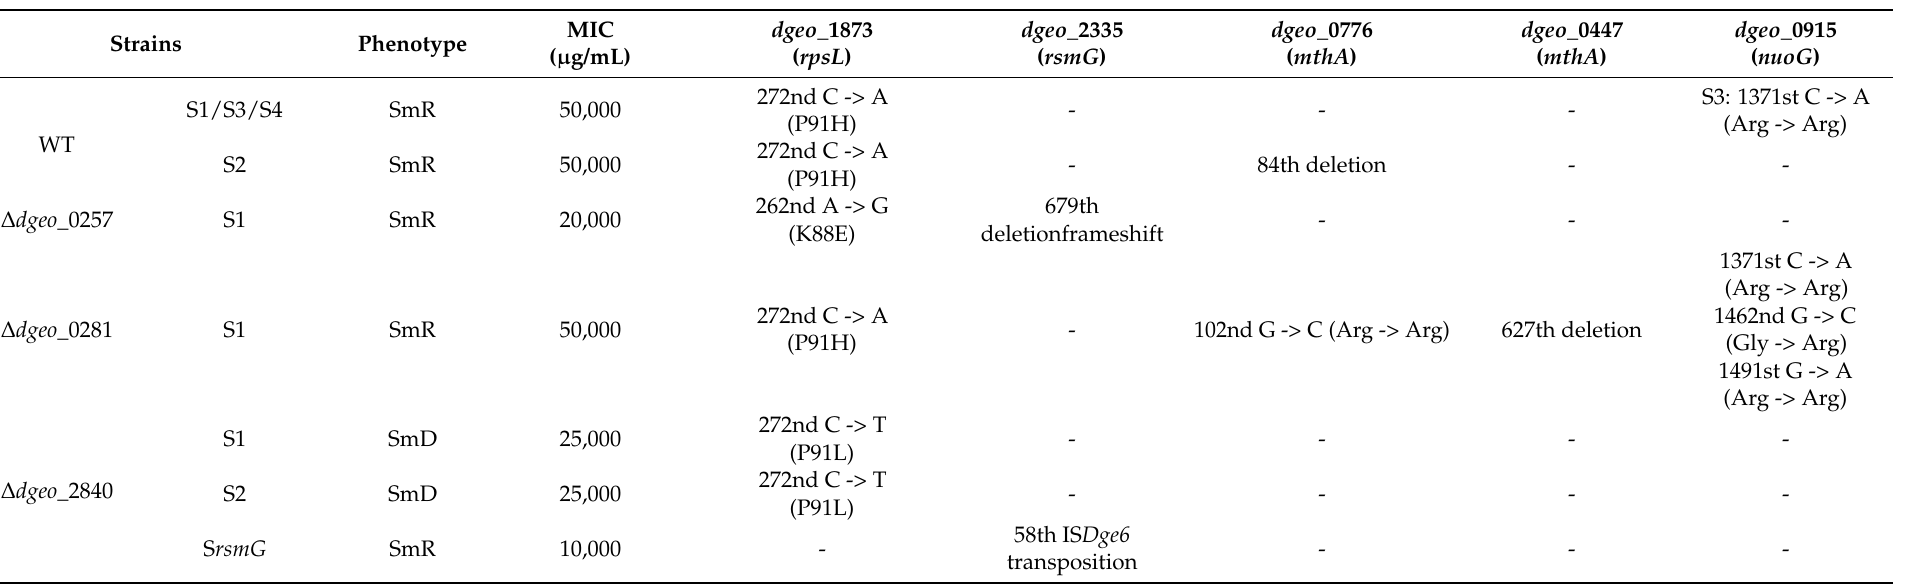
Table 1. Detection of mutations in four streptomycin-resistant related genes and an antibiotic uptake gene, their streptomycin MIC values, and their